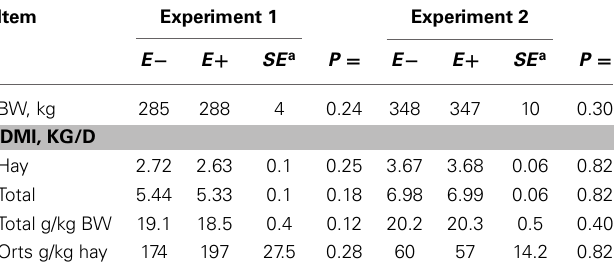
steers fed endophyte-free (E − ) or endophyte-infected (E + ) fescue seed above (Experiment 1) or within (Experiment 2) their thermoneutral